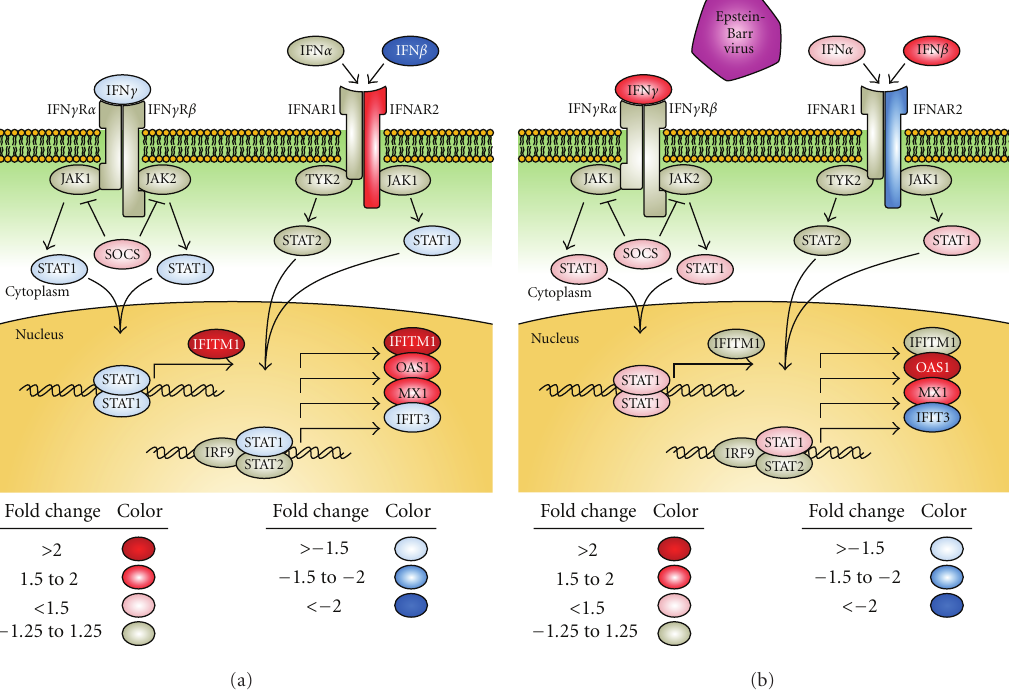
Figure 1: Association of the canonical interferon pathway with the IRF5 haplotype. Na¨ıve B cells were either exposed to EBV for 16 hours or left unstimulated. Whole-genome expression levels were compared between cells with the risk and protective haplotypes using the Illumina platform. Significant association of the data set with the canonical IFN pathway was discovered using Ingenuity Pathway Analysis ( P < 0 . 01) . Interactions between genes in the interferon pathway based on Ingenuity Pathway Analysis are shown for both the unstimulated (a) and the EBV-infected conditions (b). Blue gene symbols represent genes with relatively lower expression in the cells with the risk haplotype, while genes with red shading are upregulated in the risk cells. IFIT3: IFN-induced protein with tetratricopeptide repeats 3, SOCS: suppressor of cytokine